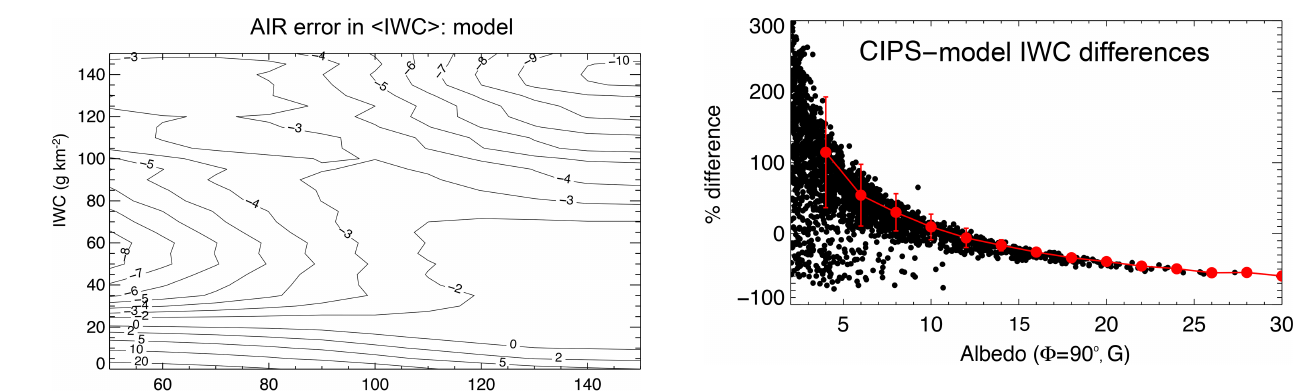
Figure 3. Differences of IWC derived from the model cloud data and the accurate IWC from the model, plotted against the 265nm albedo (in G units; see text), evaluated at SA = 90 ◦ . The error bars are the standard deviations in intervals of